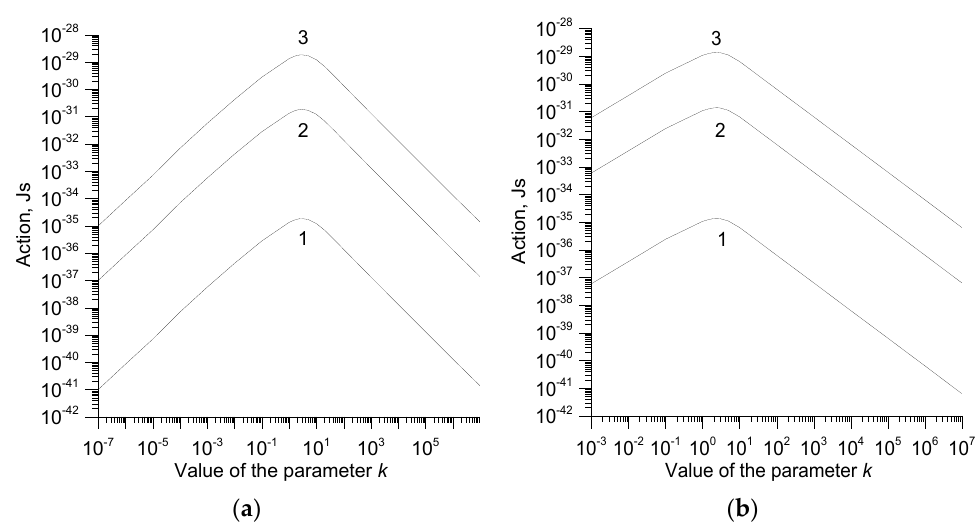
Figure 9. Same as Figure 8 except that the current waveform is given by ( a ) Equation (23); ( b ) Equation (24).